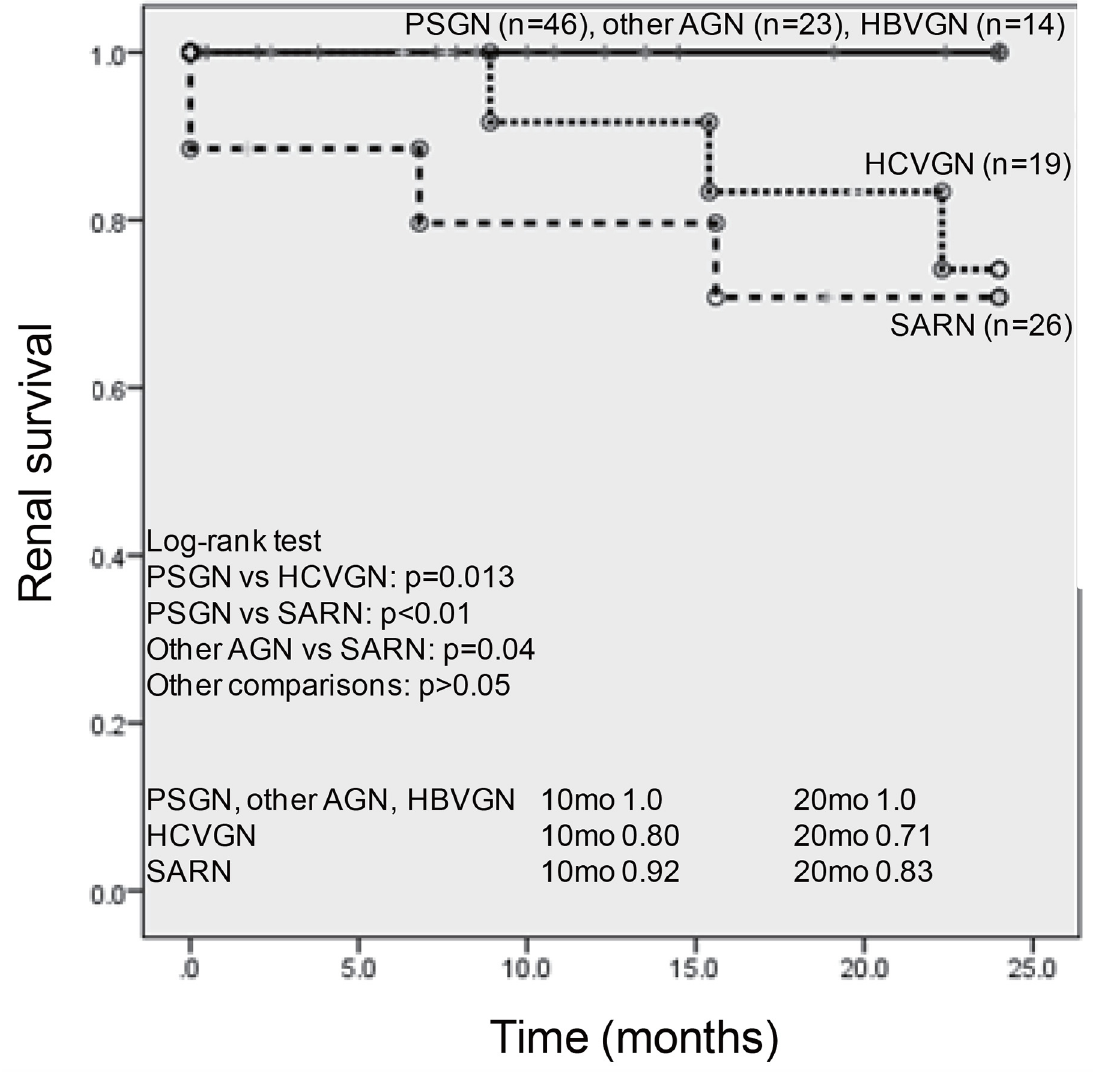
Fig 1. The comparison of renal survival rates in each PIGN group. PSGN, post- streptococcal glomerulonephritis; other AGN, acute GN except for streptococcal infection or undetermined of streptococcal infection; SARN, staphylococcus aureus infection-related nephritis; HBVGN, hepatitis B virus infection-associated GN; HCVGN, hepatitis C virus infection-associated GN. n.s.: not significant, mo: months.